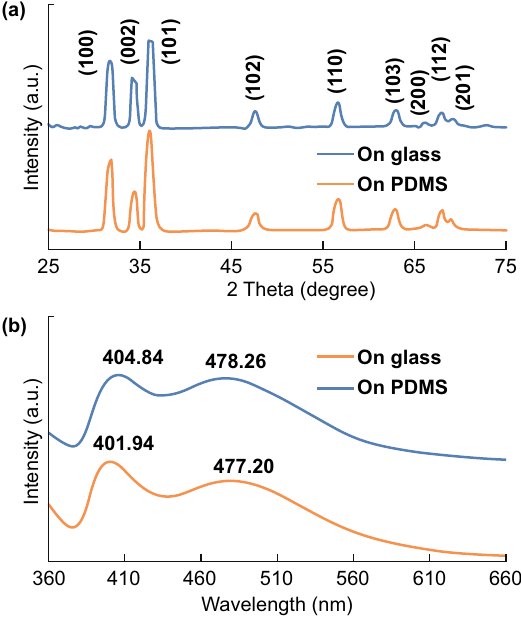
Fig. 4 a XRD patterns of the ZnO NW array. b Photoluminescence spectrum of the ZnO NW